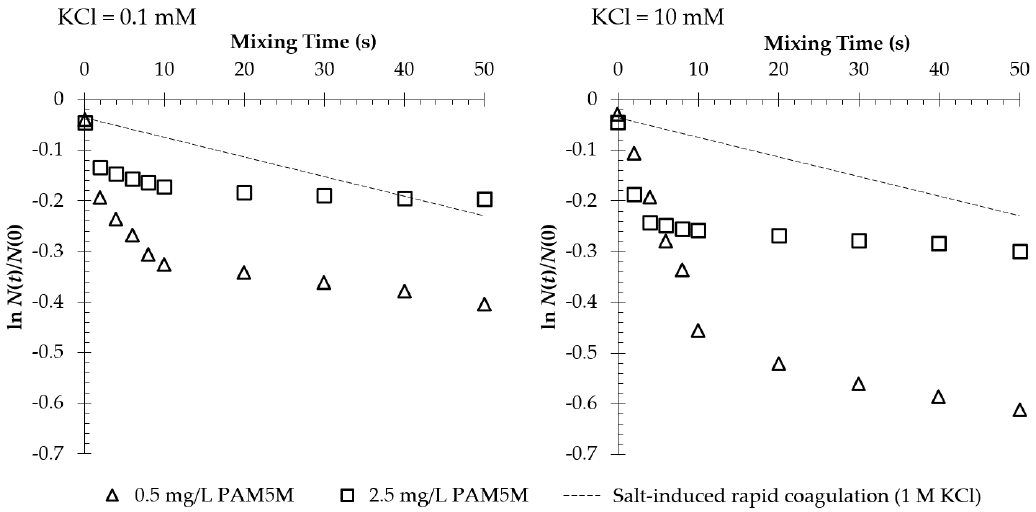
Figure 5. Temporal variation of polycation-induced flocculation rate in 0.1 and 10 mM KCl. Table 2. Enhancement factors obtained for polymer-induced flocculation under different conditions.